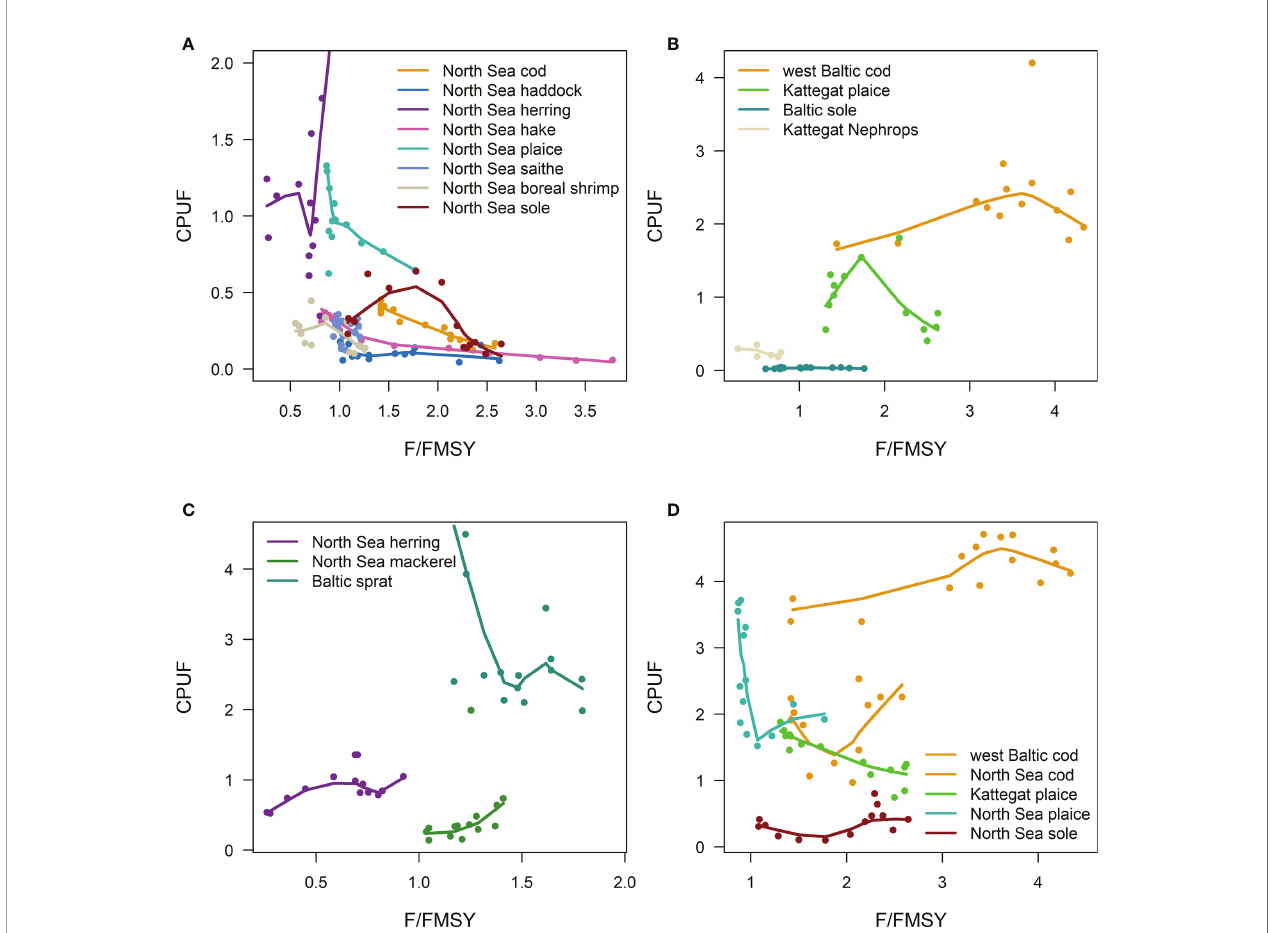
FIGURE 8 | The EU common fi sheries policy (CFP) fi sheries performance indicator F/FMSY ratio in function of landings volume (kg) per unit fuel (CPUF) estimated annually over the period 2005-2019, (A) for North Sea stocks targeted by large Danish vessels using bottom-contacting gears, (B) for Baltic stocks targeting by large Danish vessels using bottom-contacting gears, (C) For North Sea pelagic stocks targeted by large Danish vessels, (D) for stocks targeted by the small Danish vessels (<12m). The dots are annual estimates and the curves depict a smoothed line obtained over each stock speci fi c